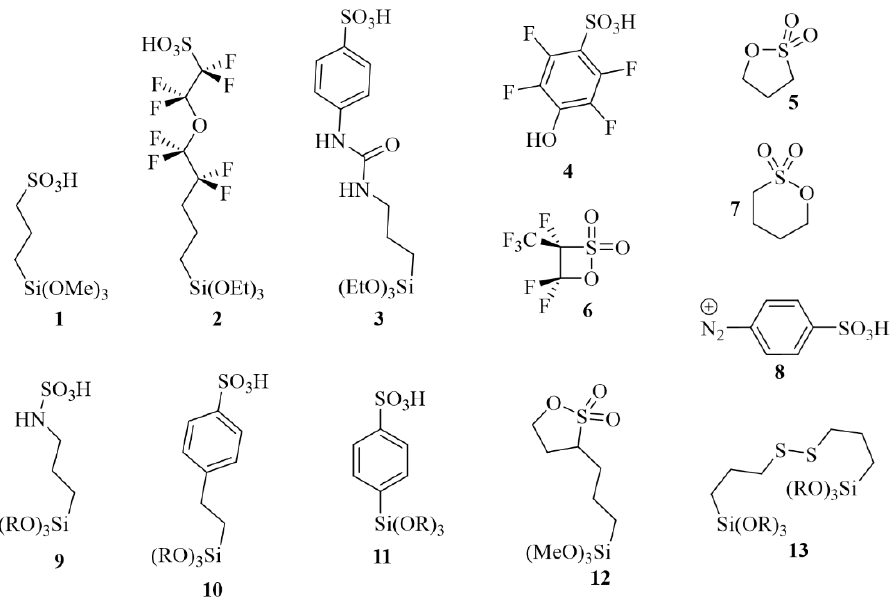
Figure 14. List of some of the precursors implemented in the synthesis of silica supported sulfonic acids [52].